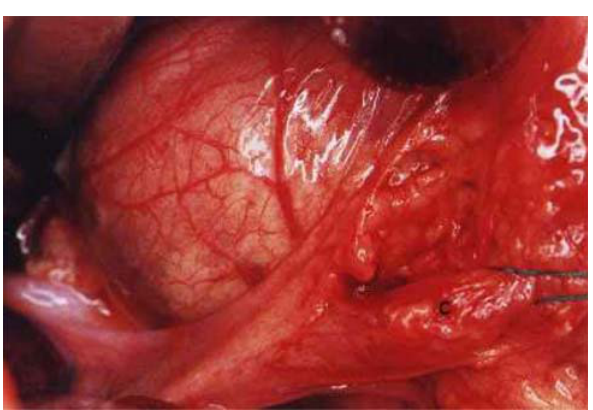
FIGURA 2 - Fotografia do ato operatório que mostra o colédoco (C) isolado junto ao